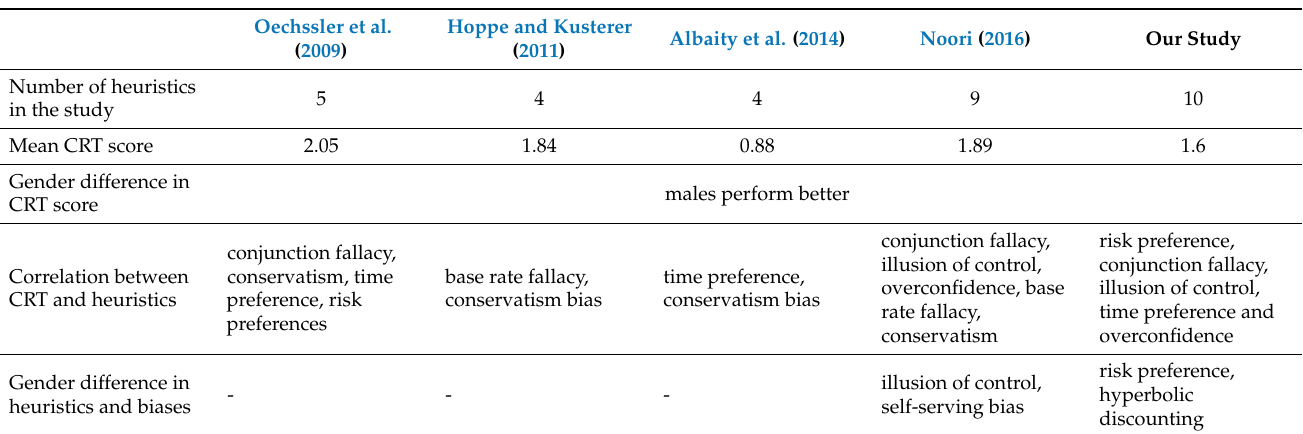
Table 7. Principal results of selected